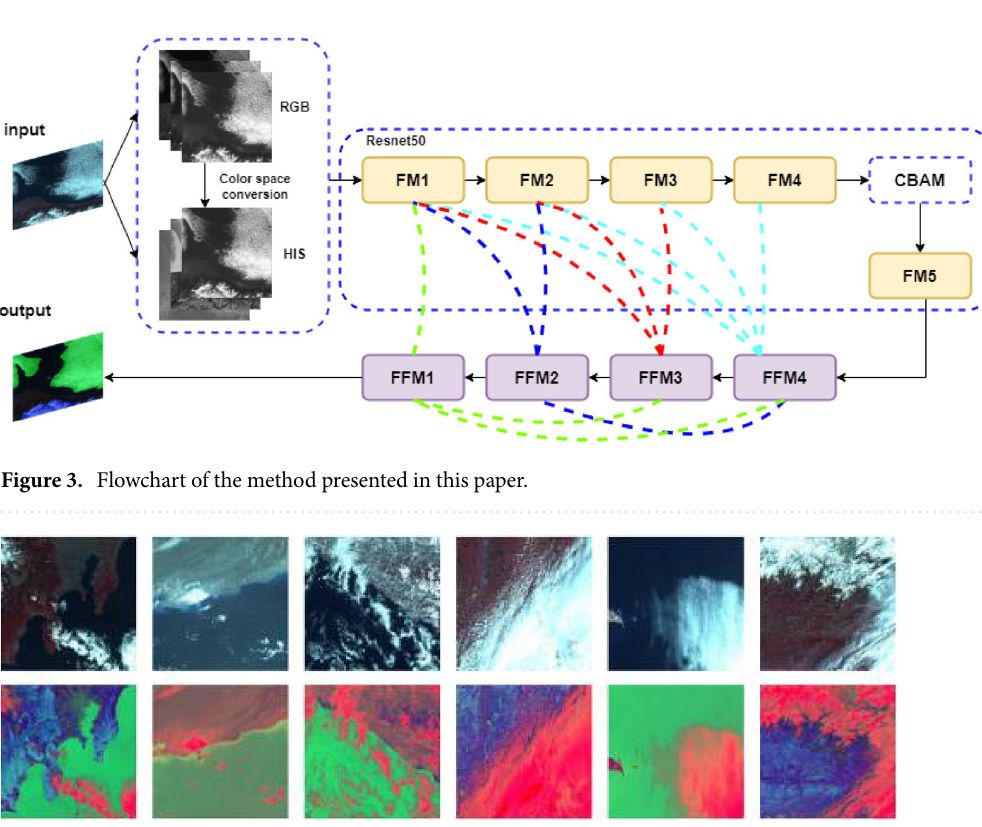
Figure 4. Schematic diagram of color space conversion results. Among them, the first behavior RGB image, the second behavior transformed HIS